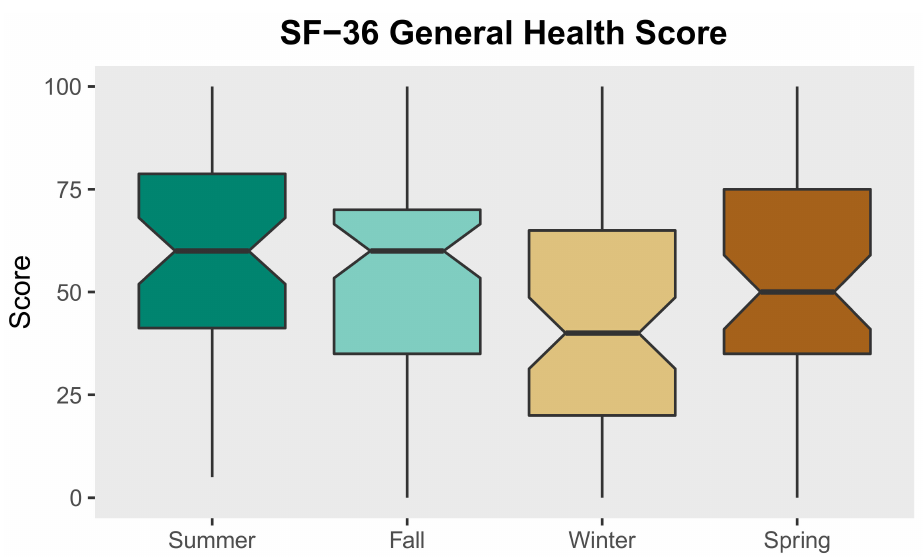
Figure 3. Boxplots of SF-36 general health scores stratified by survey